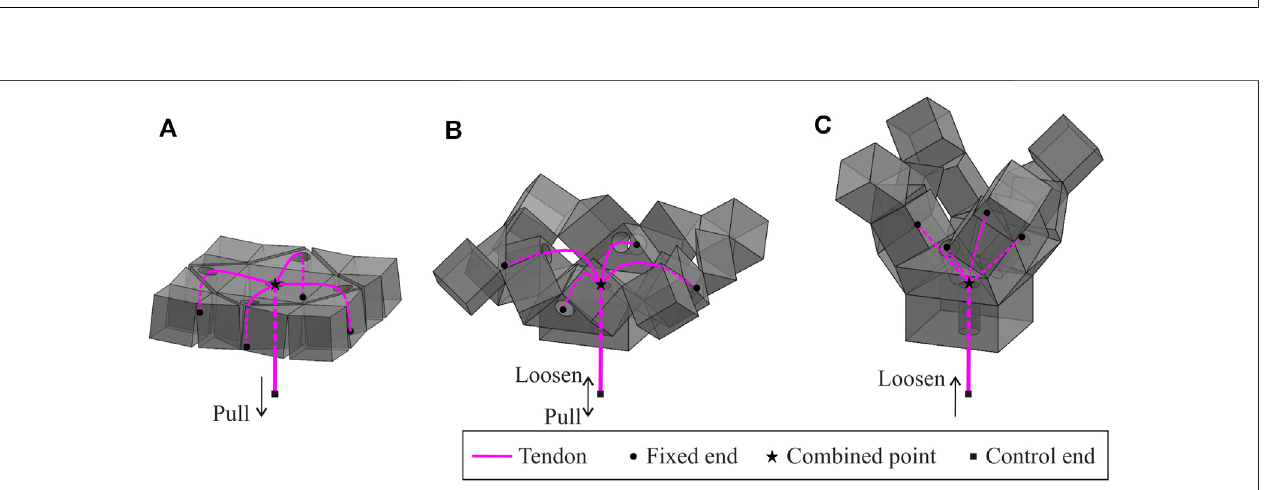
Frontiers in Robotics and AI |